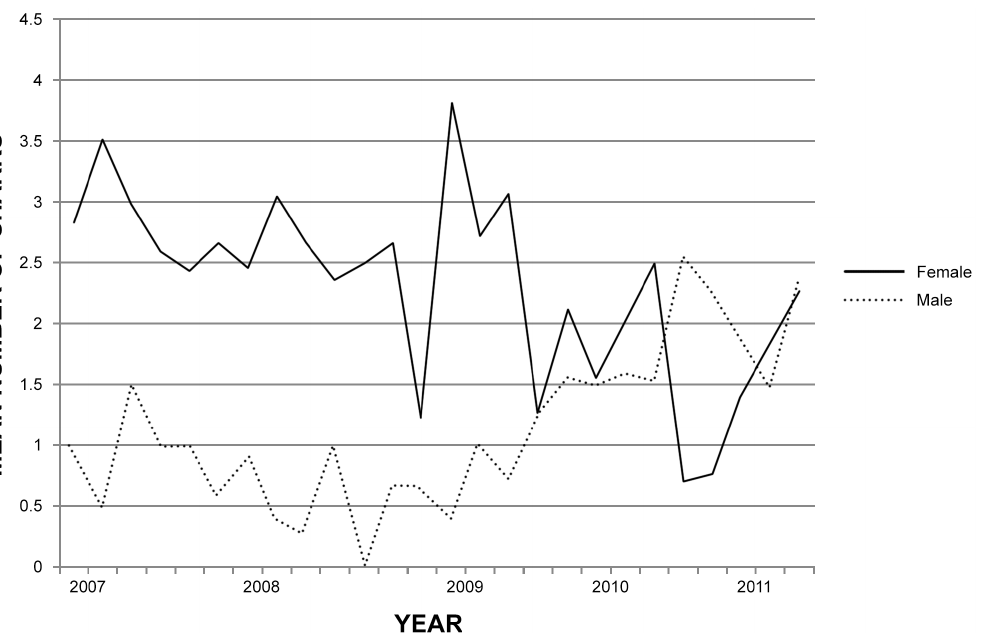
Figure 3. Interannual variability in the mean number of male and female shark sightings per trip at the inshore site in Gansbaai, 2007 to 2011.